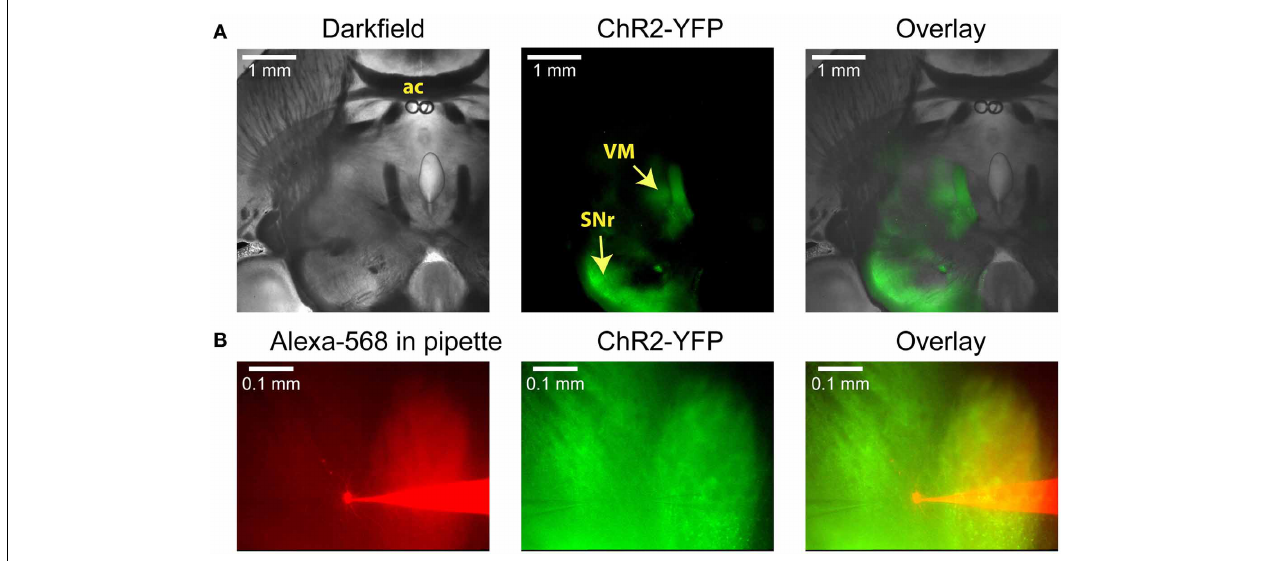
FIGURE 1 | Anatomical images illustrating a typical experiment. (A) Low-power images of a horizontal slice containing both the SNr and the VM. This level corresponds to Plate 144 in the Paxinos atlas (Franklin and Paxinos, 2008). AAV5 virus carrying YFP-tagged ChR2 under the control of the synapsin promoter was injected into the SNr, where it infected neurons